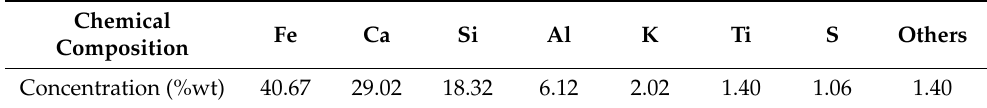
Table 3. Chemical composition of fly ash.